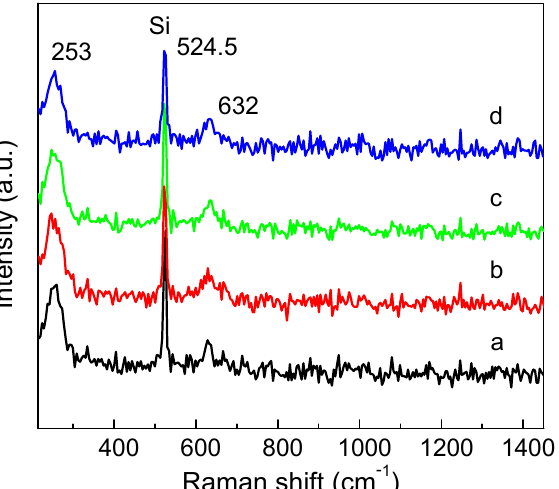
Figure 3. Raman spectra of Cu 3 P nanofilm taken at different locations with different thickness: ( a ) 10 nm; ( b ) 7 nm; ( c ) 5 nm and ( d ) 4 nm, respectively.